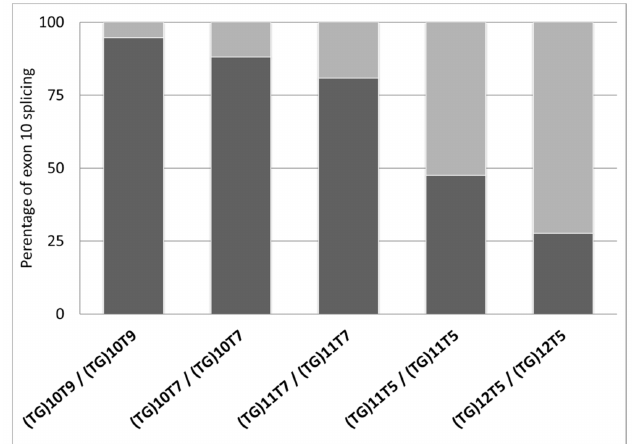
Figure 3. Relative splicing quantification of (TG)mTn genotypes. The average percentage of both wild-type (exon 10+; dark grey part of columns) and mutated (exon 10 − ; light grey part of columns) CFTR mRNA in the homozygous (TG)mTn genotypes analyzed is shown; the overall contribution of each genotype is set to 100%.